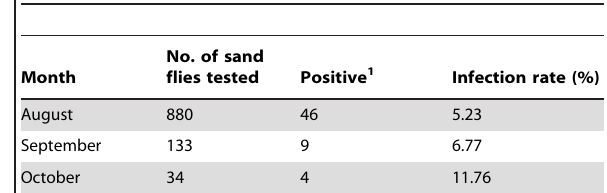
Table 4. Leishmania infection rate in Phlebotomus papatasi females throughout the sand fly season of 2009 in Sde